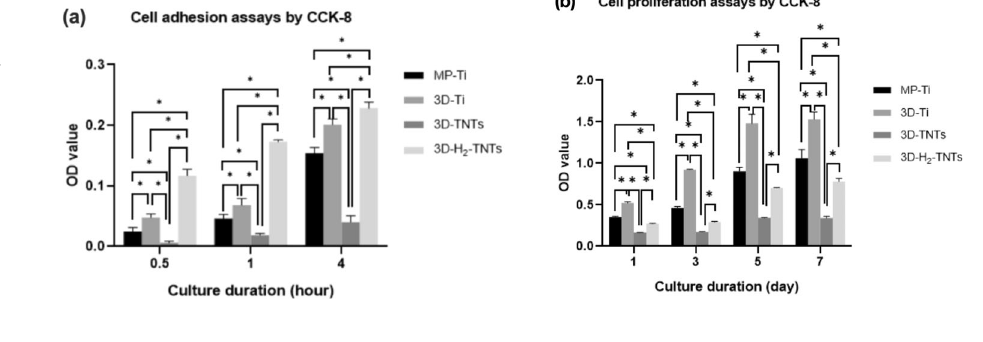
Fig. 7 ELISA and RT – qPCR results. a Concentration of FN synthesized by HGFs on the four groups samples after 4 h and 1 day. b RT – qPCR detection of the adhesion-related gene expression of HGFs cultured on the four groups of samples for 4 h and 1 day with statistical signi fi cance by * p < 0.05.